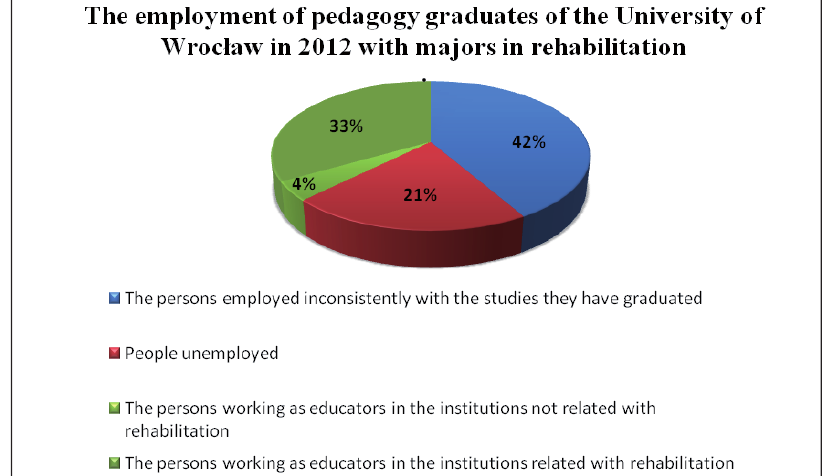
Fig. 1. The employment situation of pedagogy graduates of University of Wroc ł aw with majors in rehabilitation in 2012